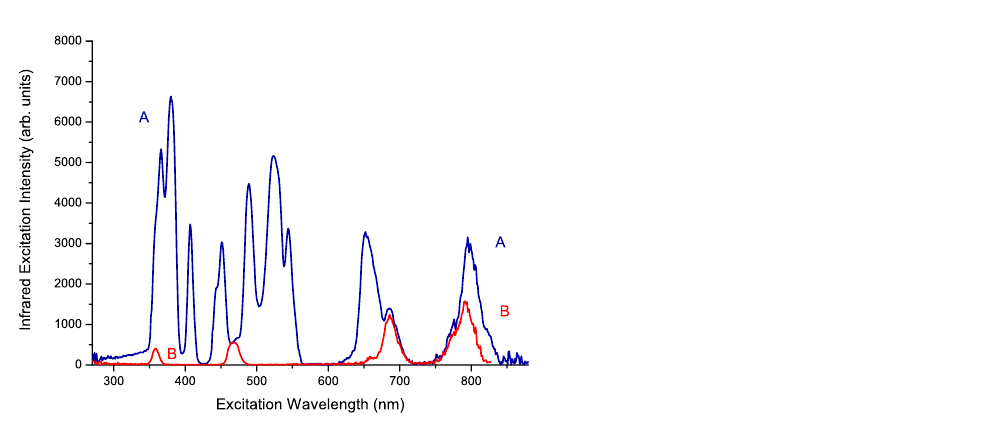
Figure 3. Infrared excitation spectra of samples (A) Er 3 + (8%)Tm 3 + (0.5%):telluride glass and (B) Tm 3 + (0.5%):telluride glass when monitored at 1800 nm for the 3 F 4 → 3 H 6 luminescence of the Tm 3 +